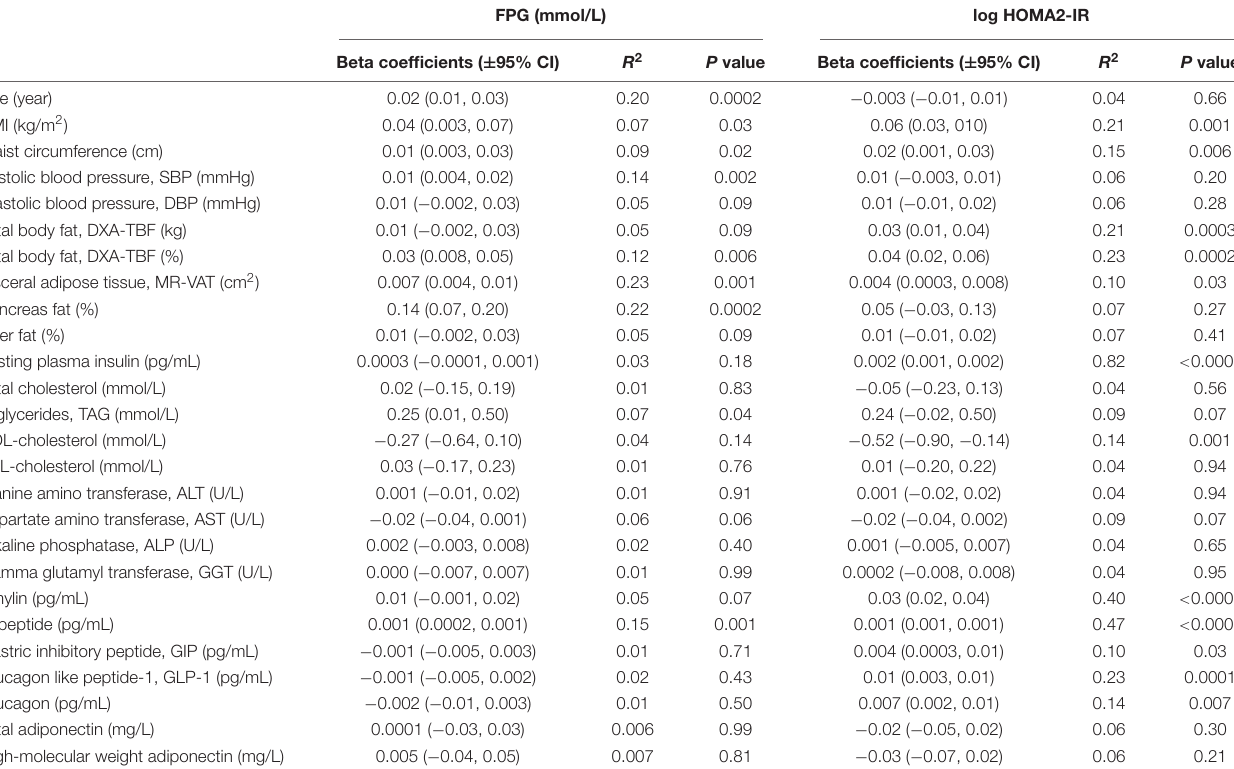
TABLE 4 | Association between (i) fasting plasma glucose (FPG) and (ii) insulin resistance (calculated using HOMA2-IR) with individual metabolic risk factors in n = 68 women that underwent MR imaging using single predictor regression